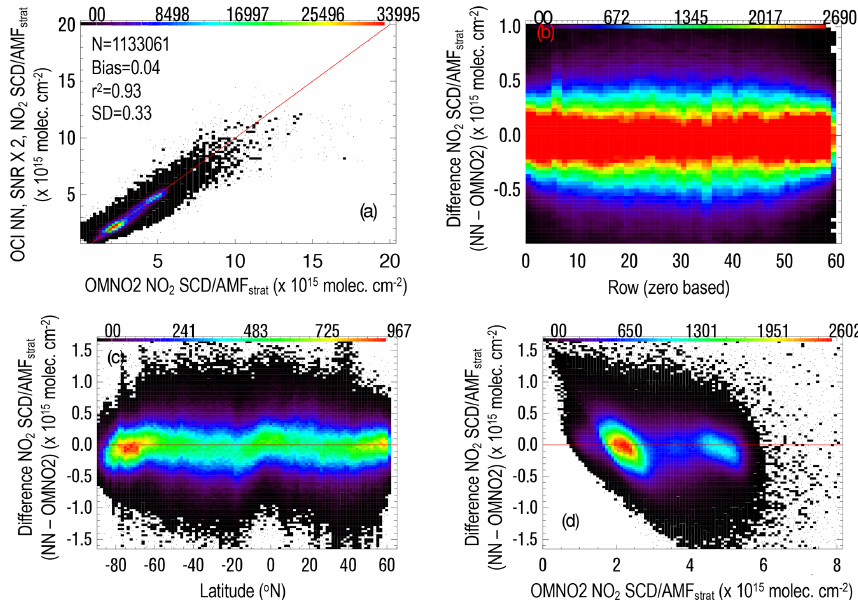
Figure 4. Global data from 28 February 2005 from a training where each point represents the result that would be obtained using the OCI spectral characteristics and SNR from Fig. 1b multiplied by 2 with a fitting window of 355–500nm; (a) density distribution (numbers along the top) of NO 2 target OMNO2 SCD (all results here are normalized with respect to the stratospheric air mass factor, AMF strat ) versus those from the NN training with statistics including the standard deviation of the difference (SD), fraction of variance explained ( r 2 ), and mean of difference between the NN and target (bias); (b–d) density distribution of the NO 2 SCD difference (NN SCD − OMNO2 SCD) as a function of OMI row number, latitude, and NO 2 SCD,